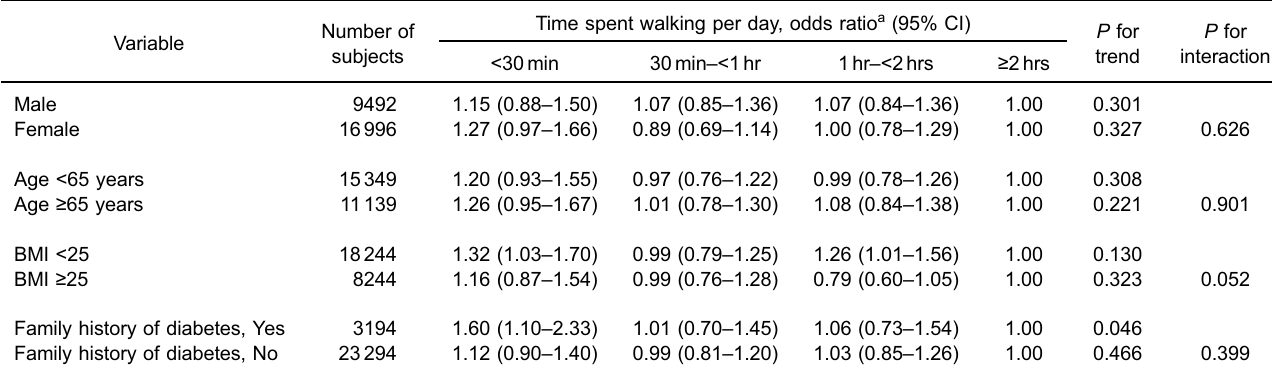
Table 3. Subgroup analyses of the association between time spent walking per day and unrecognized diabetes in terms of age, sex, BMI, and family history of diabetes (cross-sectional analysis) Variable